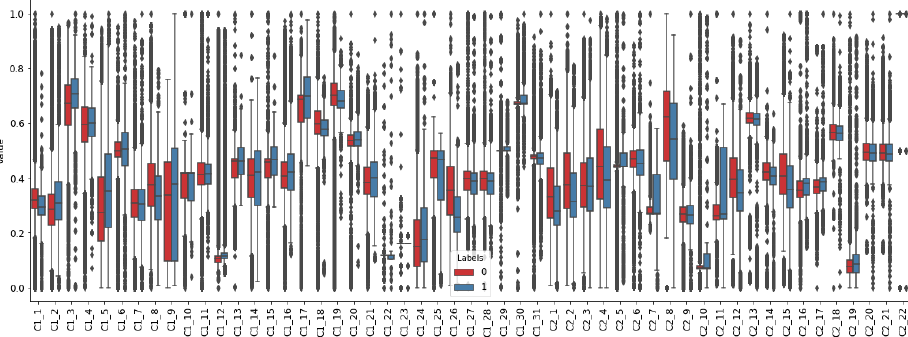
Figure 8. Box-plot of the features distinguishing between class membership of the samples.